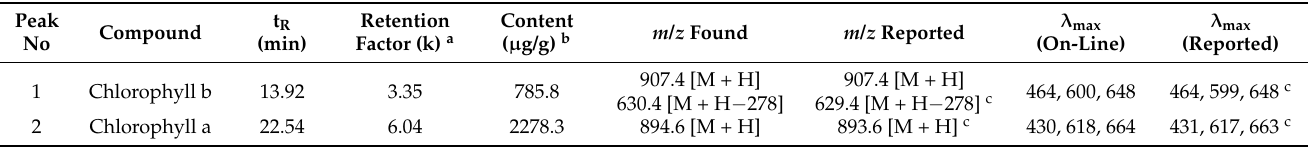
Table 1. Retention time (t R ), retention factor (k), separation factor ( α ) and contents ( μ g/g) of chlorophylls in Pomelo leaves.